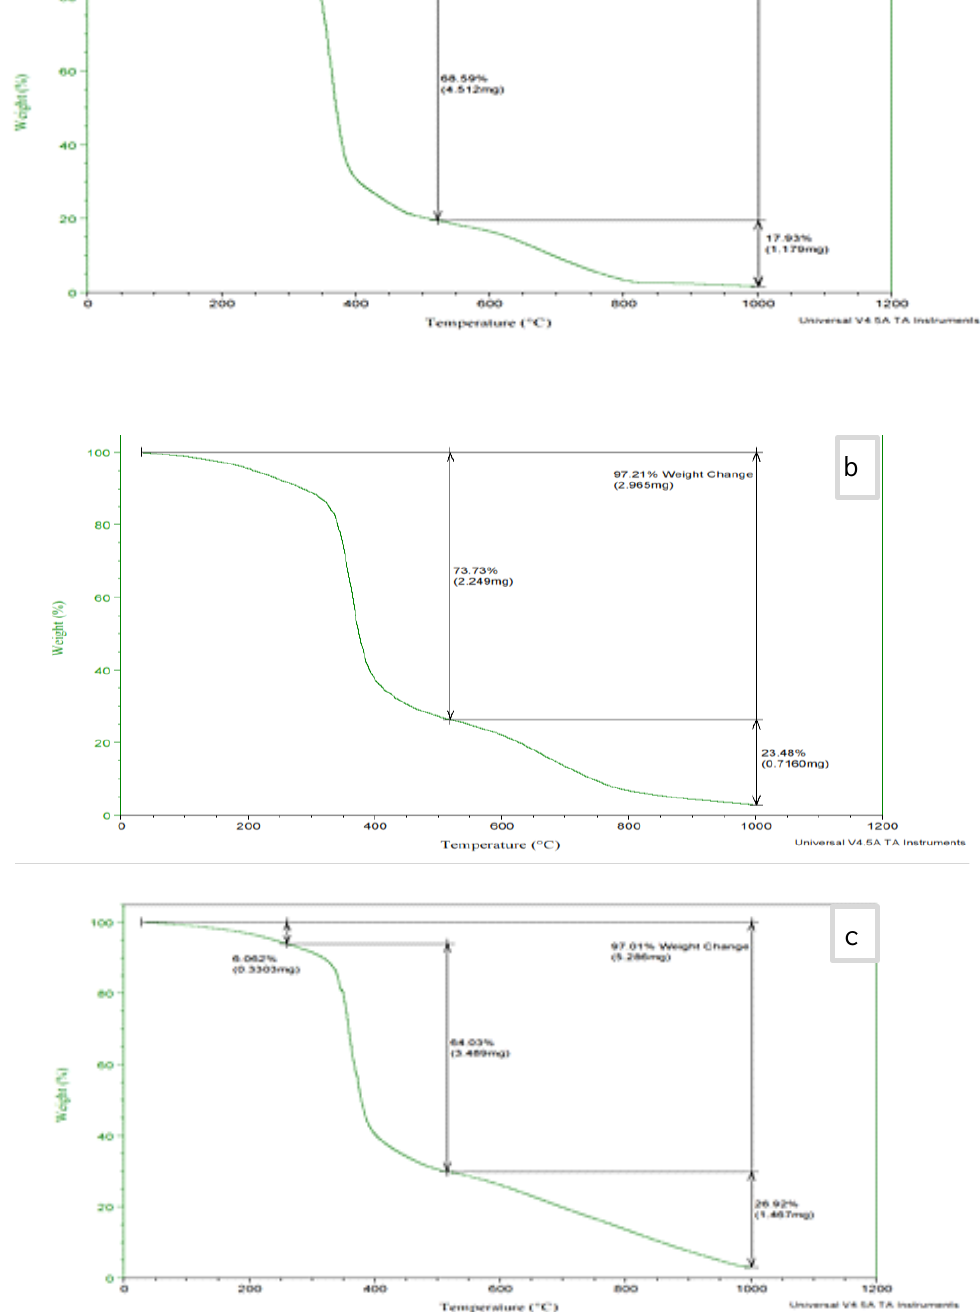
Figure 6: Weight loss as a function of temperature: a. blend, b. 1%Gr, and